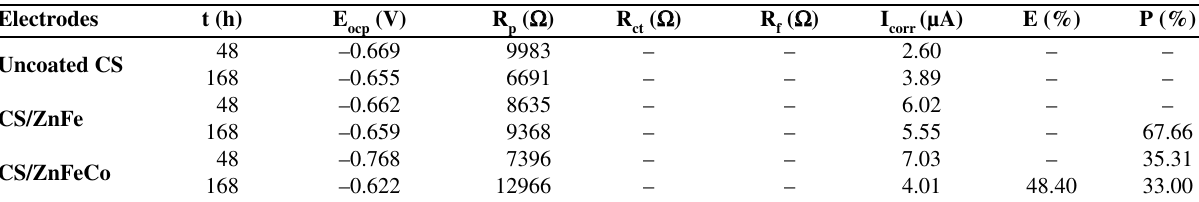
= 170 mV dec –1 for bare carbon steel electrode a